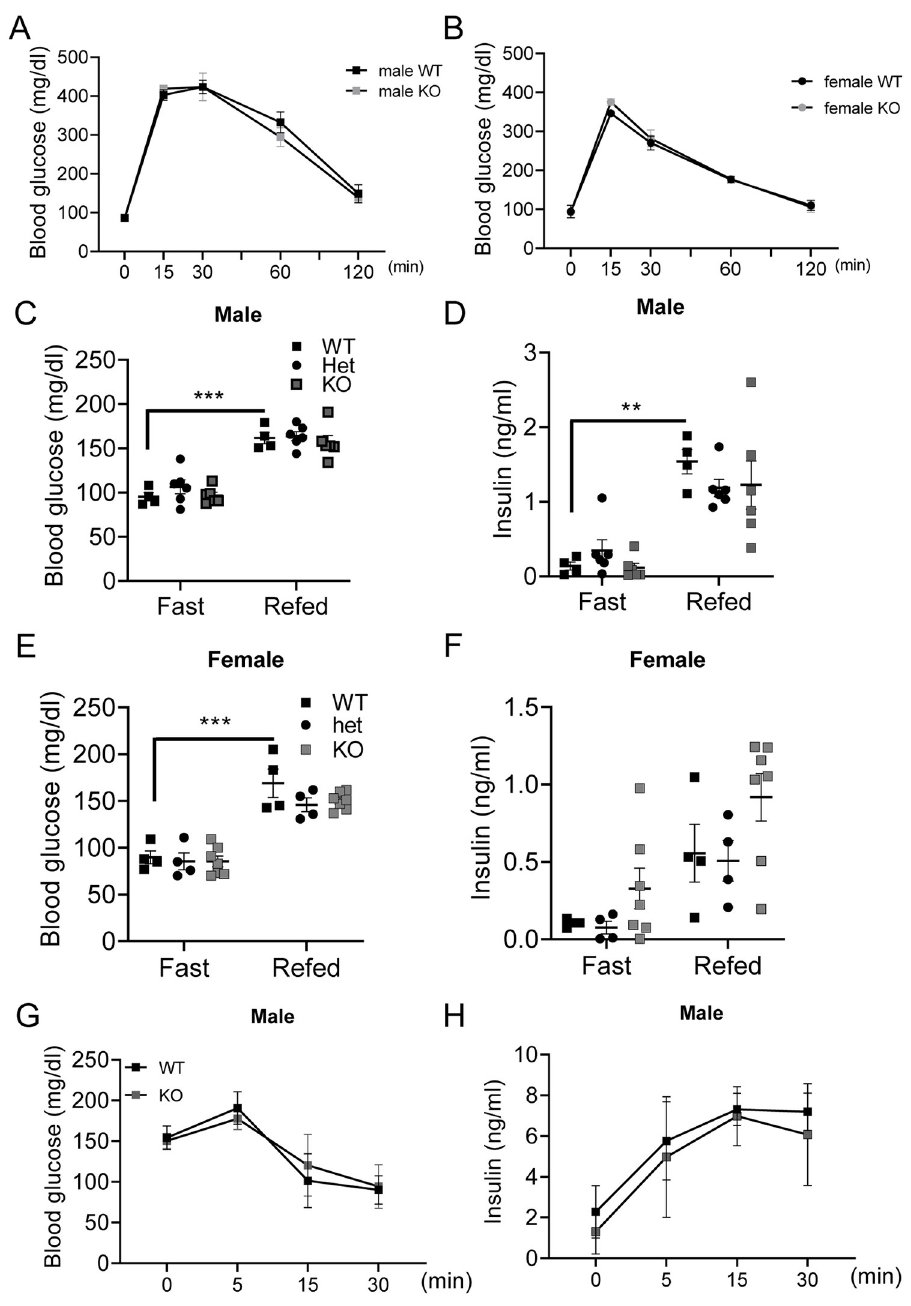
Fig 4. Whole body glucose metabolism and insulin secretion in KO mice. (A-B) Glucose tolerance tests in 16-week- old (A) male and (B) female KO mice. Male WT (n = 4), male KO (n = 6), female WT (n = 4), and female KO (n = 6). (C-F) Glucose and insulin concentrations in heterozygous (Het) and homozygous KO mice fasted overnight (Fast) or fasted overnight and then refed for 1h (Refed). (C) Blood glucose and (D) insulin levels in male mice. Male WT (n = 4), male Het (n = 6), and male KO (n = 6). (E) Blood glucose and (F) insulin levels in female mice. Female WT (n = 4), female Het (n = 4), and female KO (n = 7). (G) Blood glucose and (H) insulin levels in male KO mice after intraperitoneal injection of glibenclamide (5 mg/kg). WT (n = 5), and KO (n = 3). All values represent mean ± SEM. �� p < 0.01, ��� p < 0.001 by